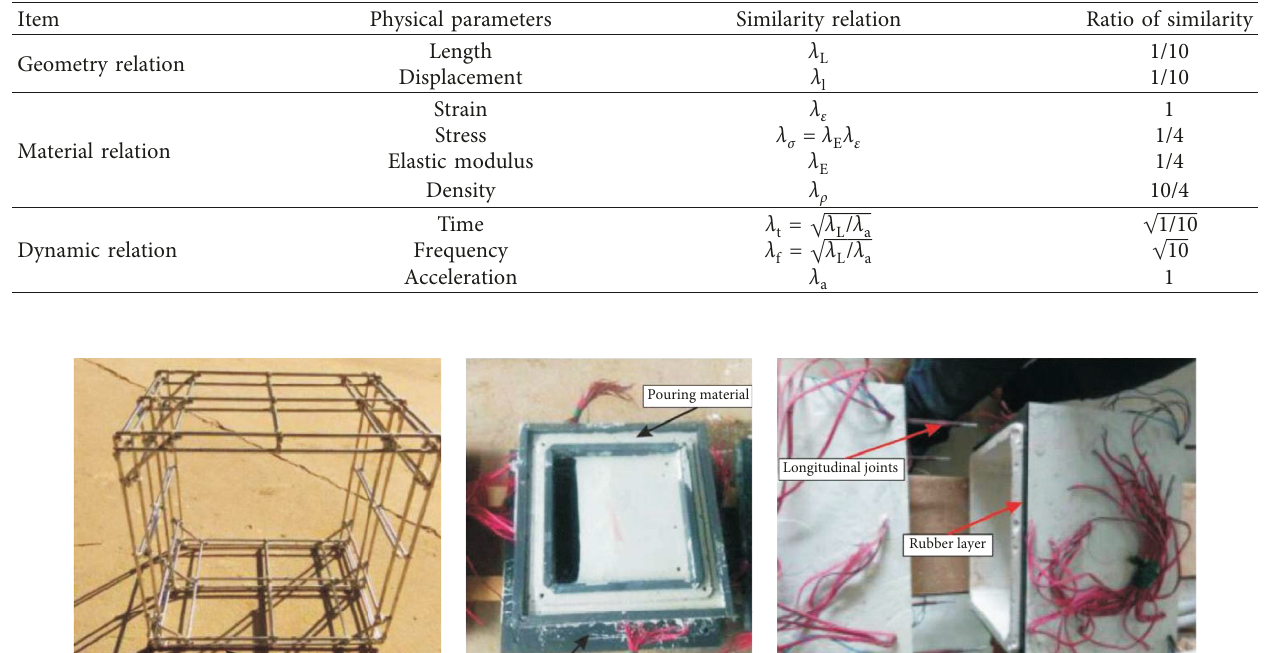
Table 1: Similarity laws of the model